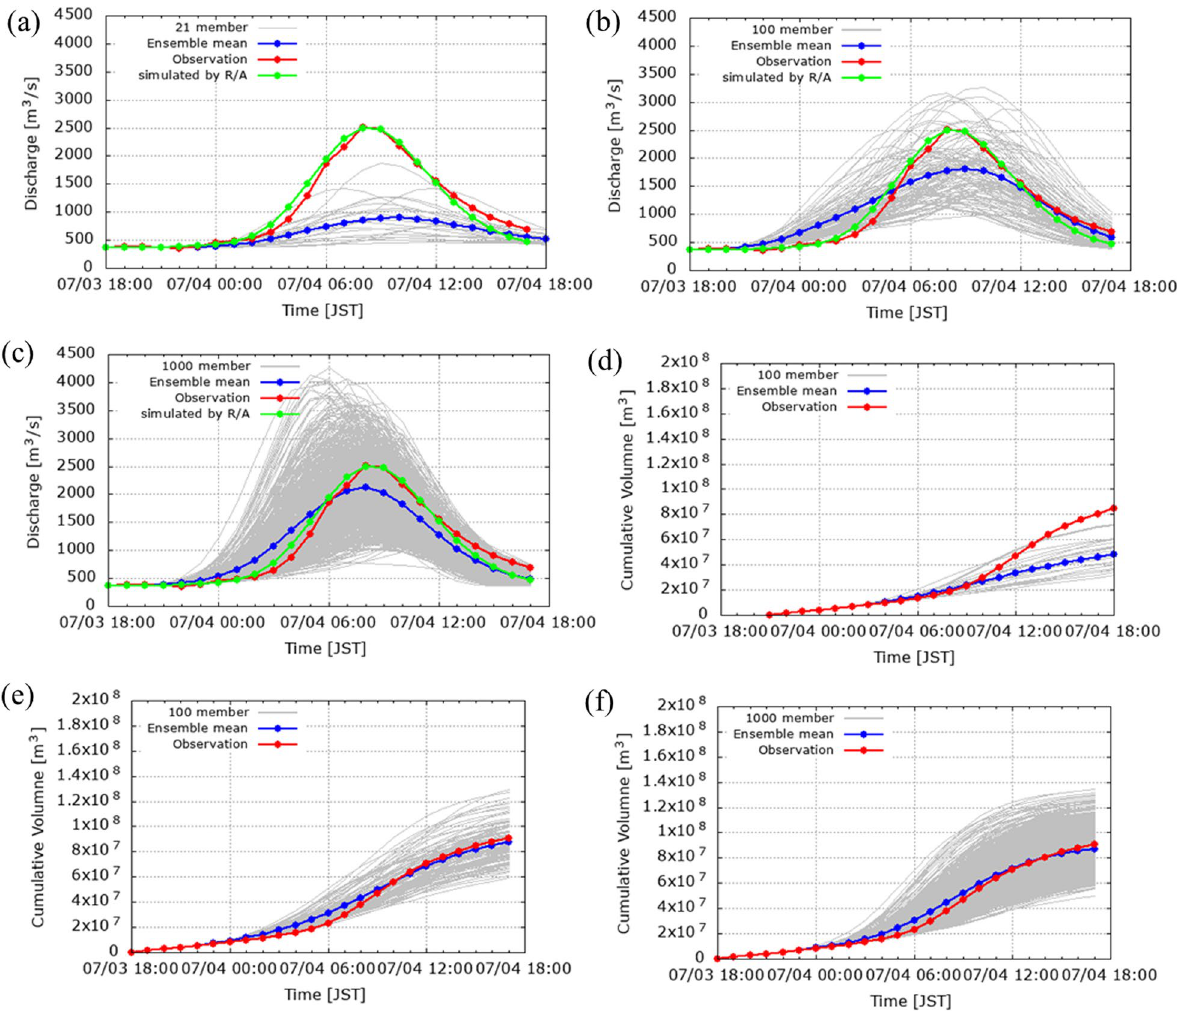
Fig. 13 Observed and simulated discharge to Kawabegawa dam catchment. a – c Hourly discharge of ( a ) 21 members (MEPS), ( b ) 100 members (LETKF) and ( c ) 1000 members (LETKF). d – f Cumulative discharge for ( d ) 21 members MEPS, ( e ) 100 members and ( f ) 1000